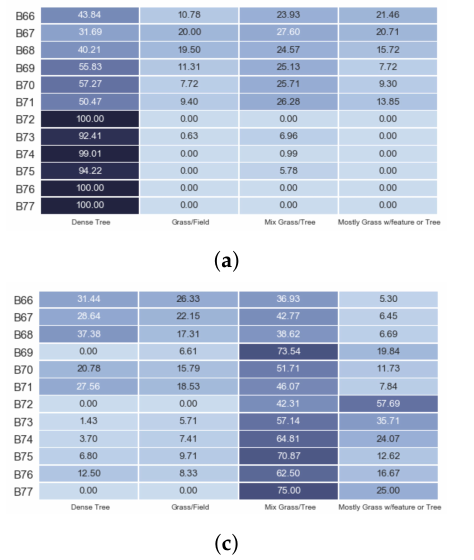
Figure 4. A sample of percentage of each cluster per block for the years: ( a ) 2011. ( b ) 2015. ( c ) 2017. The darker the blue color, the higher the percentage of the cluster in a block.